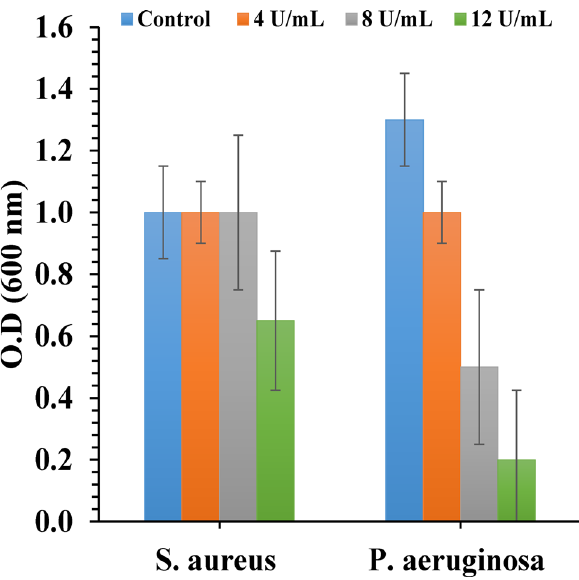
Figure 13. Biofilm dispersion of S. aureus and P. aeruginosa after 24 h of enzymatic treatments by crystal violet